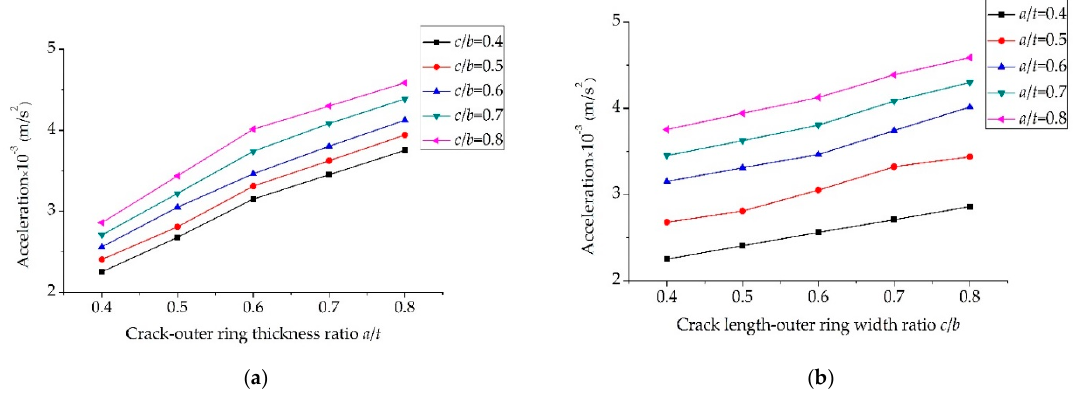
Figure 14. Fixing a/t or c/b and changing the amplitude comparison corresponding to the fault characteristic frequency obtained by another scale: ( a ) The amplitude corresponding to the fault characteristic frequency of the analog signal under different a/t conditions when c/b is constant; ( b ) the amplitude corresponding to the fault characteristic frequency of the analog signal under different c/b conditions when a / t is constant.